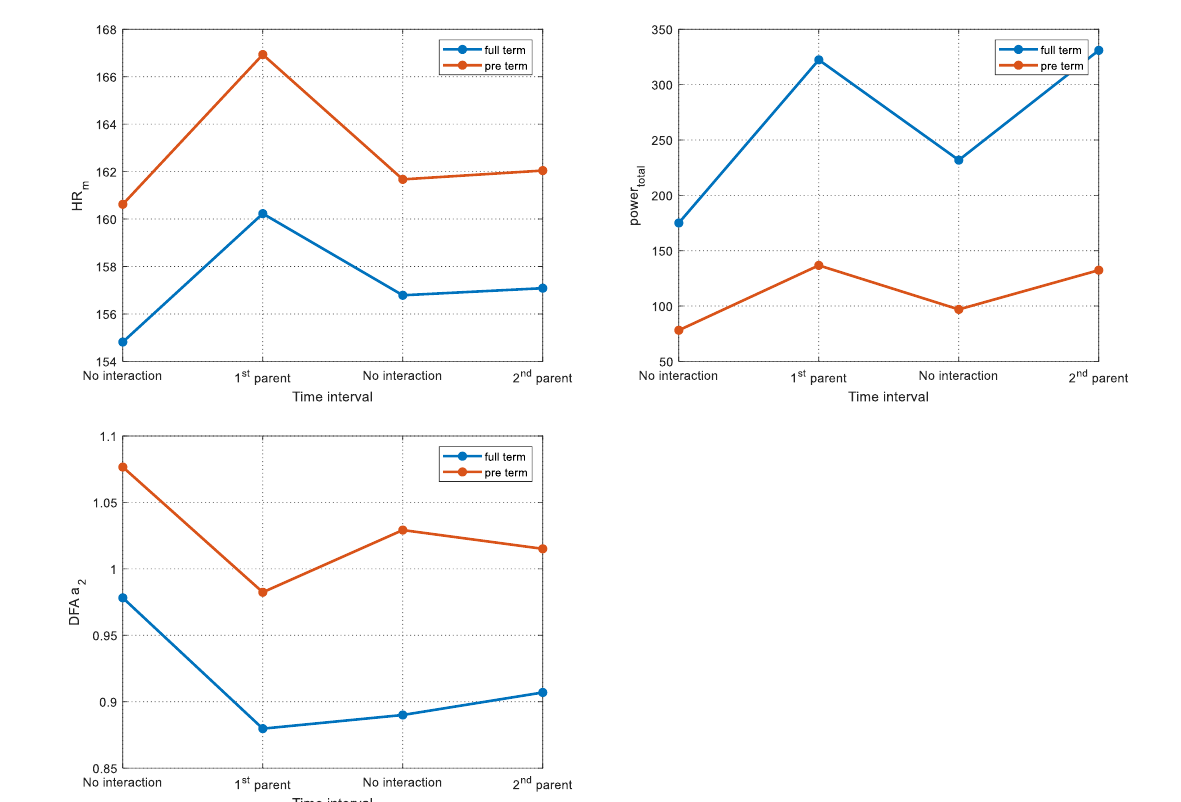
Figure 2. HRV parameters (HR m , total power, DFA α 2 ) behavior in the investigated interaction pat- terns (resting condition 1 (no interaction), interaction with the parent, resting condition 2 (no inter- action), interaction with the